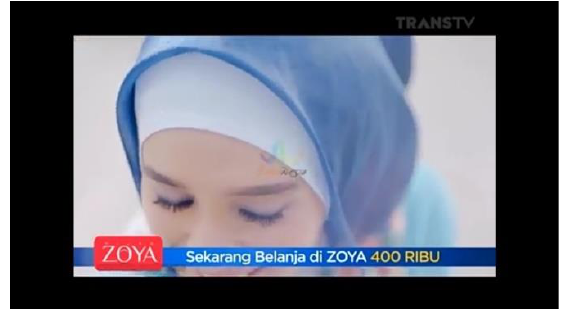
Figure 3: A Gorgeous Muslim Woman Physical